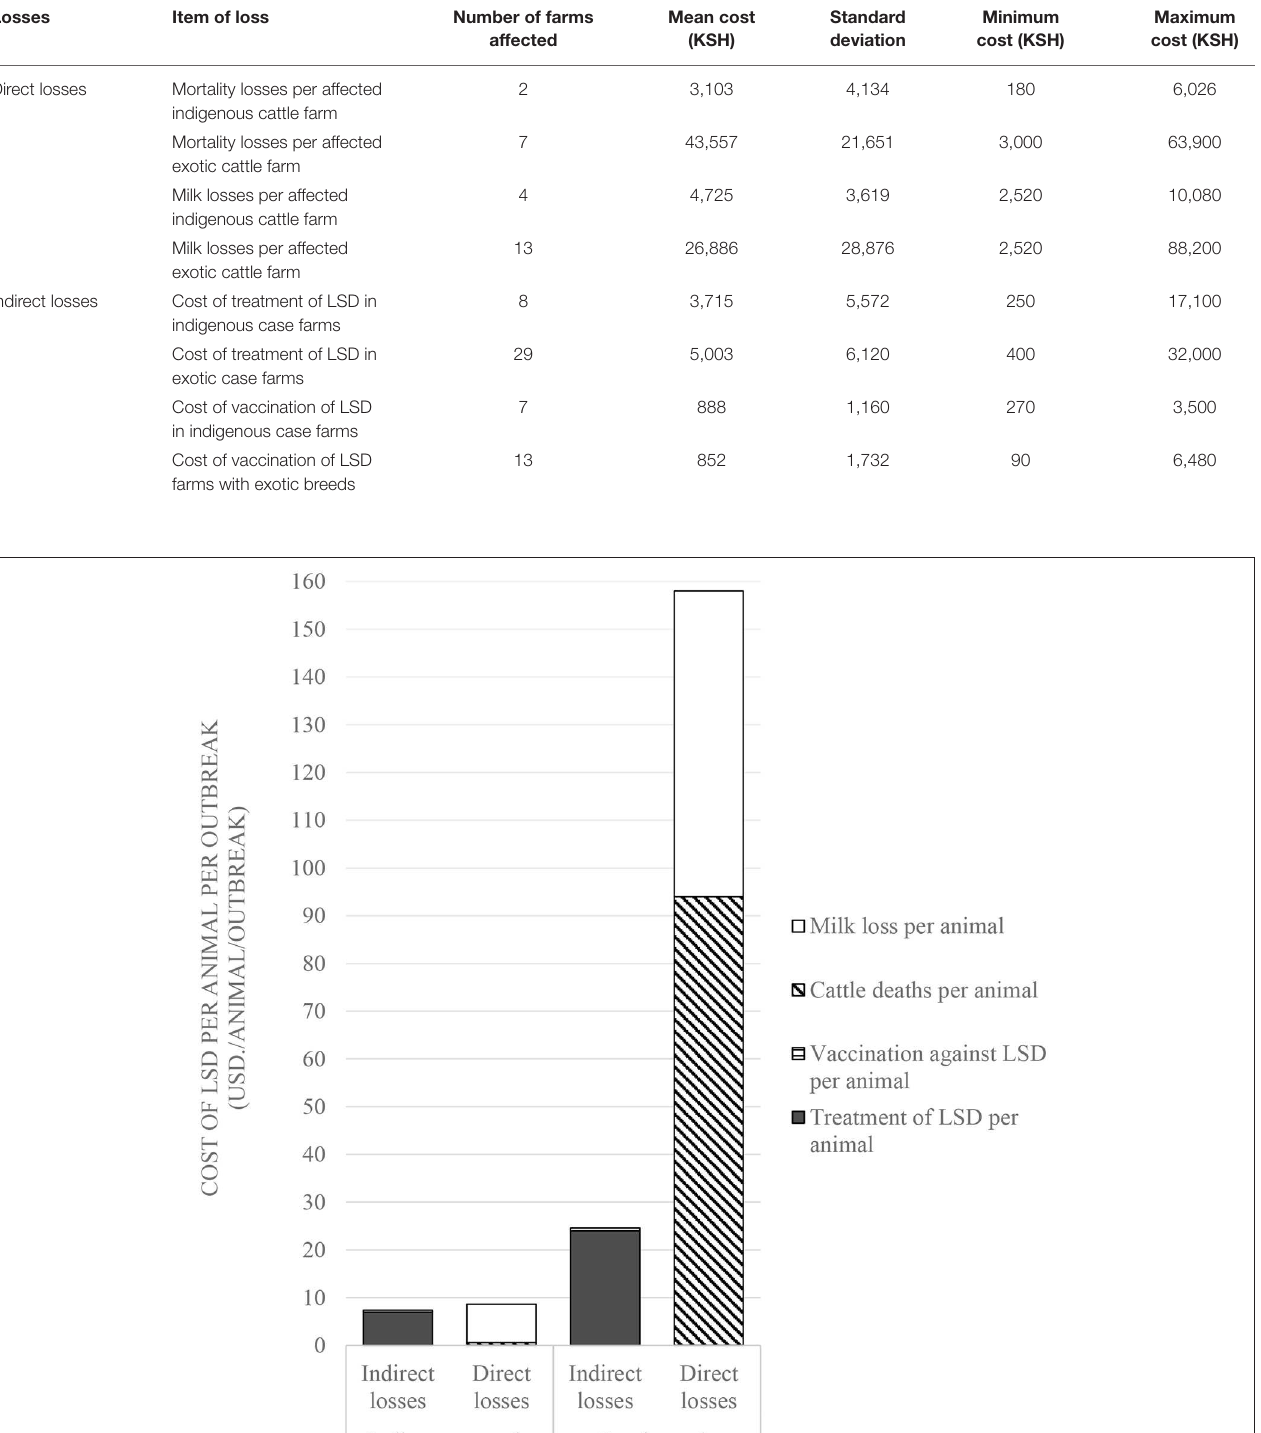
Frontiers in Veterinary Science |